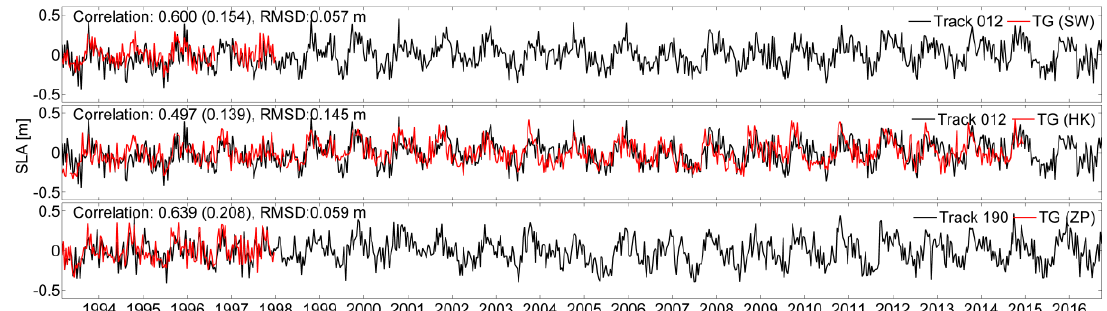
Figure 2. Comparisons of sea level anomalies (SLA) between TG data and the nearest valid along-track altimeter data. Correlation coefficients (95% confidence level (CL)) between two time series and root mean square differences (RMSDs) are shown in the upper left corner in each panel.